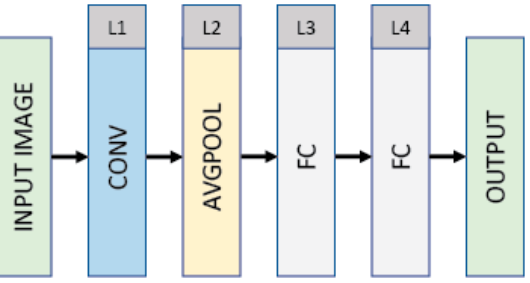
Figure 4. The architecture of the CNN variant that is utilized via the proposed approach DL.